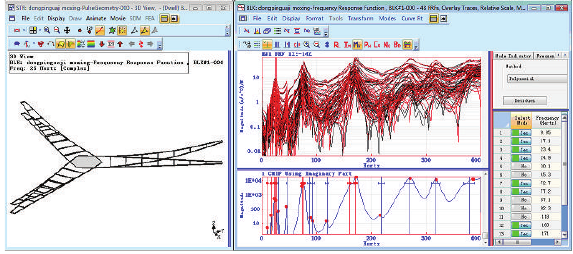
Figure 4: Vibration frequencies of blade number